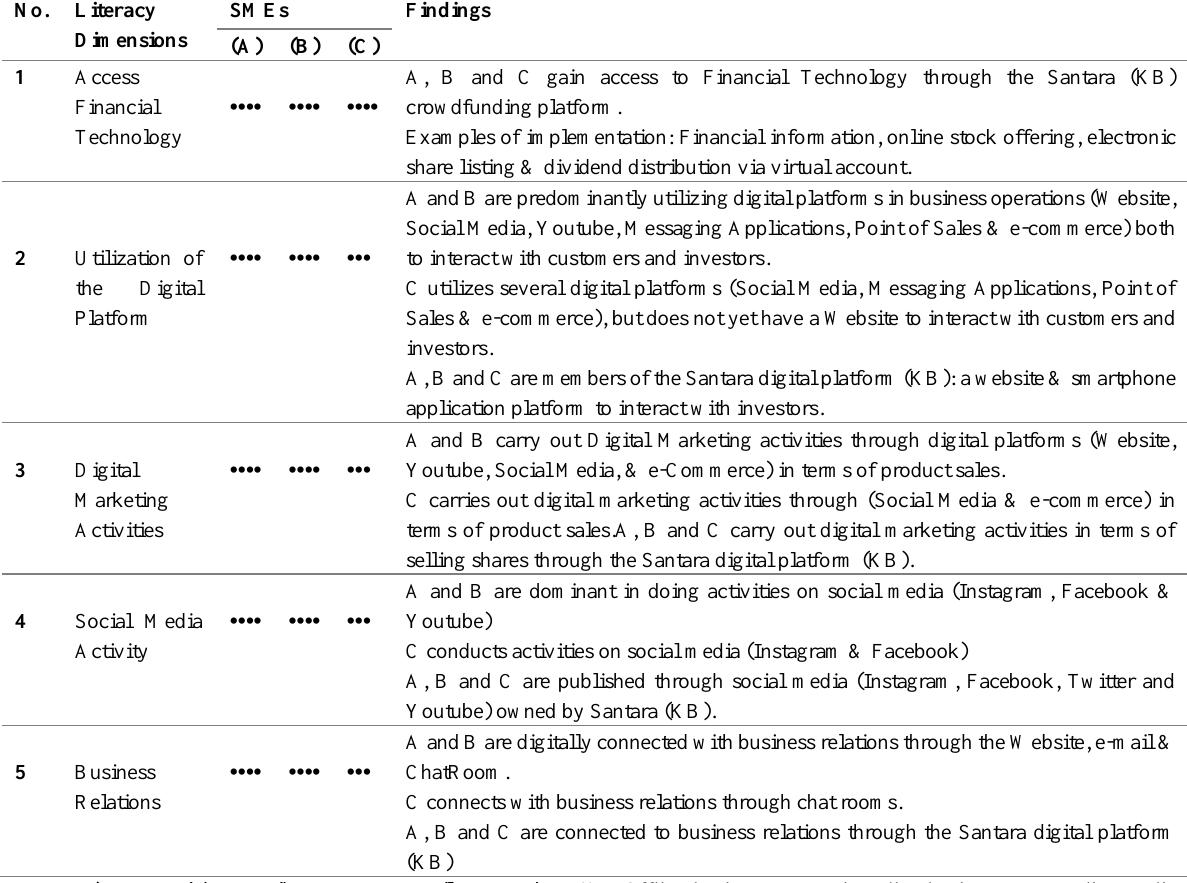
Table 2: The level of digital adoption and activity by